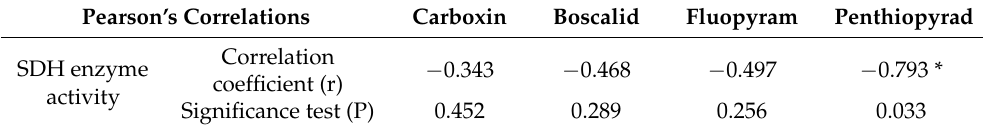
Table 3. Correlation analysis between SDH activity and the sensitivity to SDHI in double mutations. Pearson’s Correlations Carboxin Boscalid Fluopyram Penthiopyrad Correlation − 0.343 − 0.468 − 0.497 − 0.793 * SDH enzyme coefficient (r) activity Significance test (P) 0.452 0.289